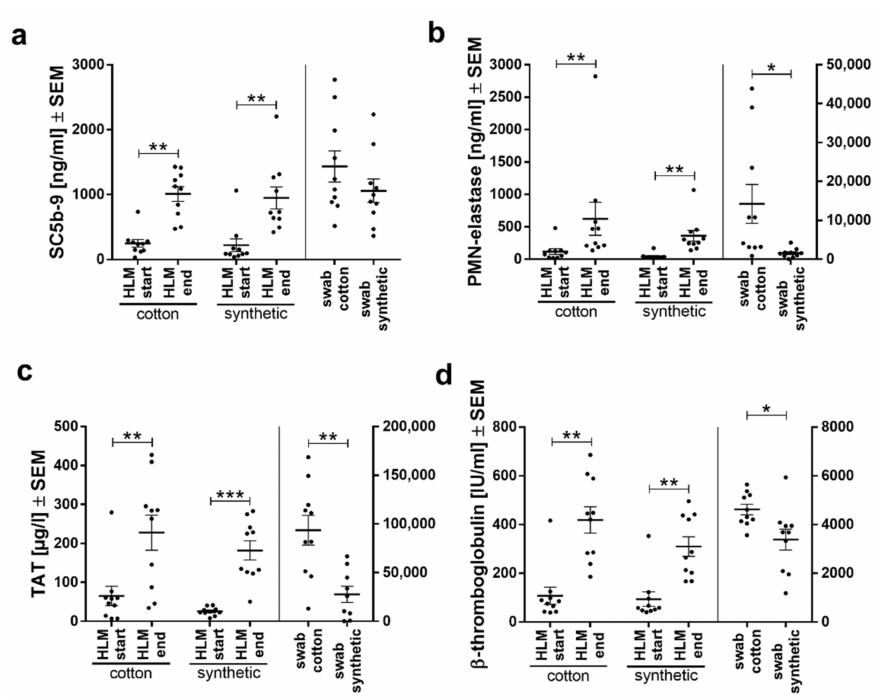
Figure 3. Hemocompatibility parameters measured from plasma of both patient groups indicate lower activation of neutrophils and platelets when synthetic swabs are used. Plasma levels of ( a ) complement, SC5b-9; ( b ) inflammation, PMN-elastase; ( c ) coagulation, TAT; and ( d ) platelet, β -TG activation from patients of both groups (cotton swabs and synthetic swabs) are presented as means ± SEM per study group. Differences were detected by Student’s t -test * p <0.05, ** p <0.01, *** p <0.001.